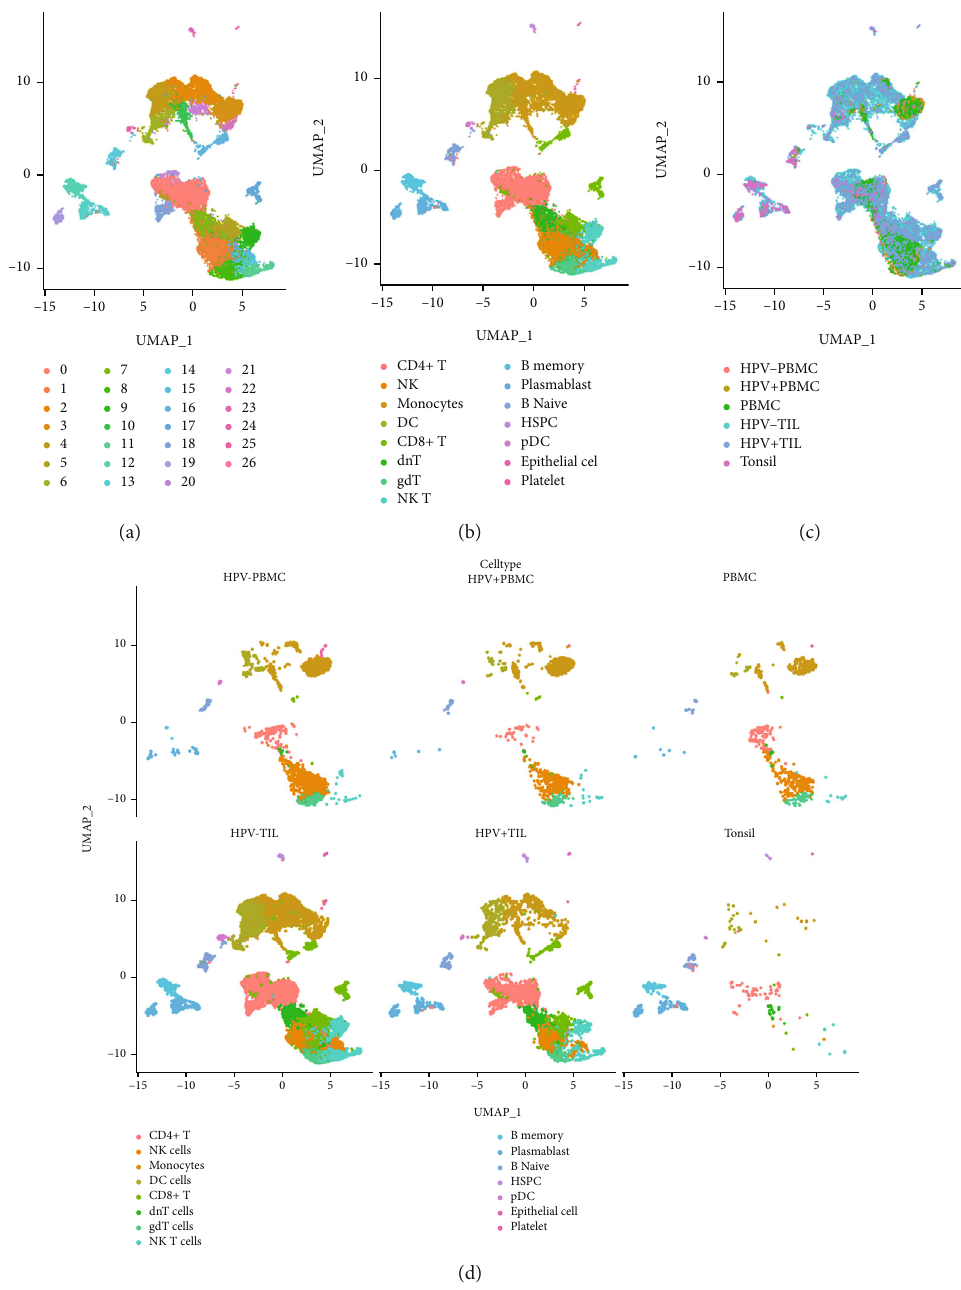
Figure 1: Single-cell RNA sequencing results from immune cells in HNSCC. (a) UMAP of 20,978 primary immune cells from peripheral and intra-tumoral CD45+ immune populations from HPV- and HPV+ HNSCC and healthy donors. (b) Cell cluster identi fi cation across the UMAP. (c) Distribution of cells by tissue type, peripheral blood from HPV-, tonsil from HPV-, peripheral blood from HPV+, tonsil from HPV+, peripheral blood from healthy donors, and tonsil from healthy donors. (d) UMAP demonstrating inferred immune cell types in HNSCC and healthy donors; clusters are colored by cell type across tissue